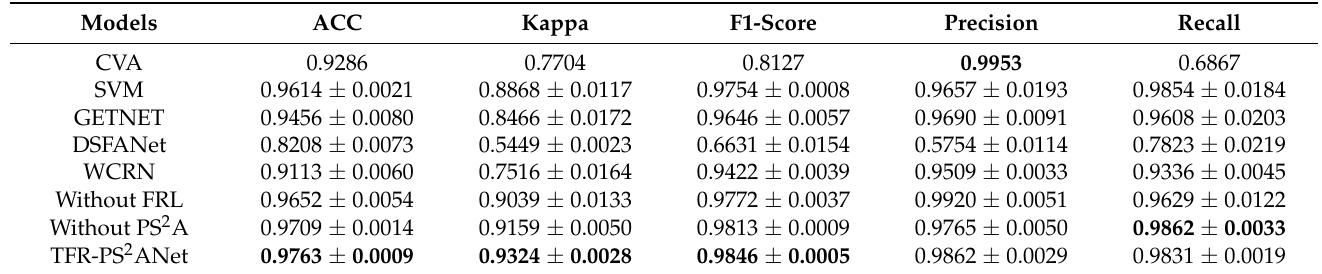
Table 2. Model comparison results and module ablation study results on the Irrigated Agriculture Dataset (repeated 3 times).